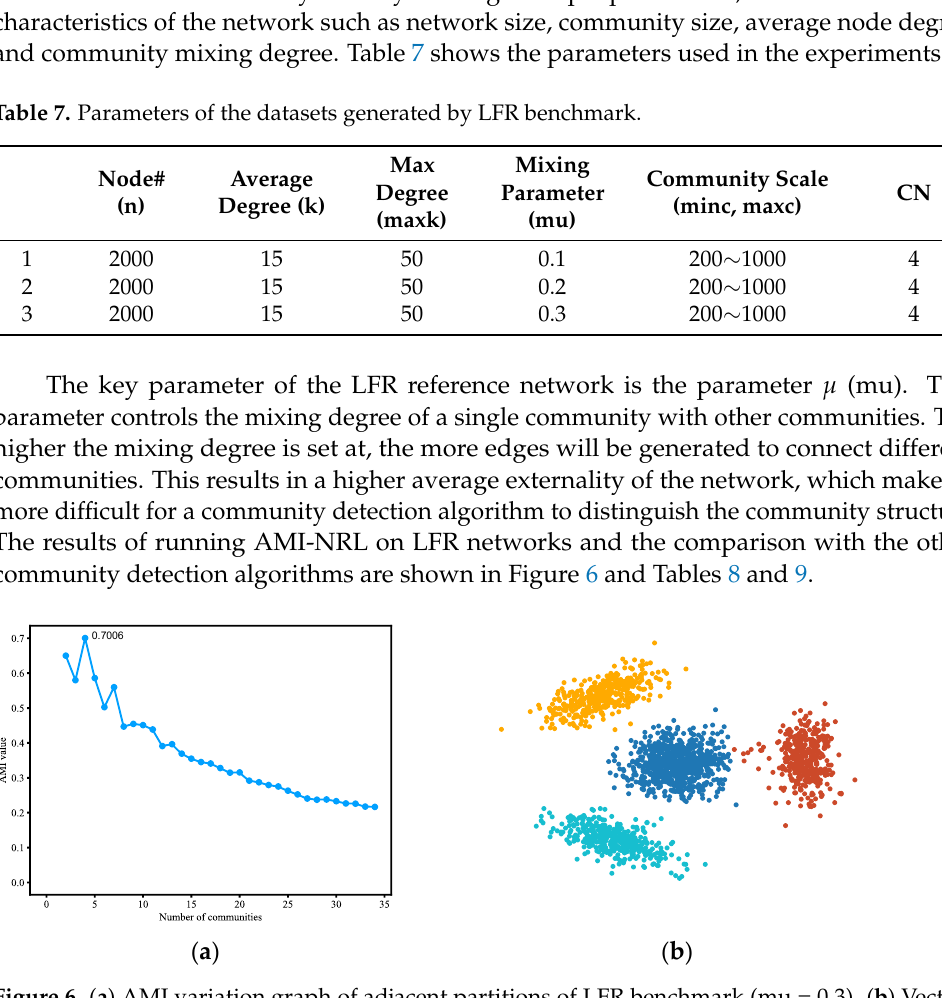
Figure 6. ( a ) AMI variation graph of adjacent partitions of LFR benchmark (mu = 0.3). ( b ) Vectors representing each node of LFR benchmark (mu = 0.3). Table 8. Results of AMI-NRL community detection on LFR benchmark datasets.